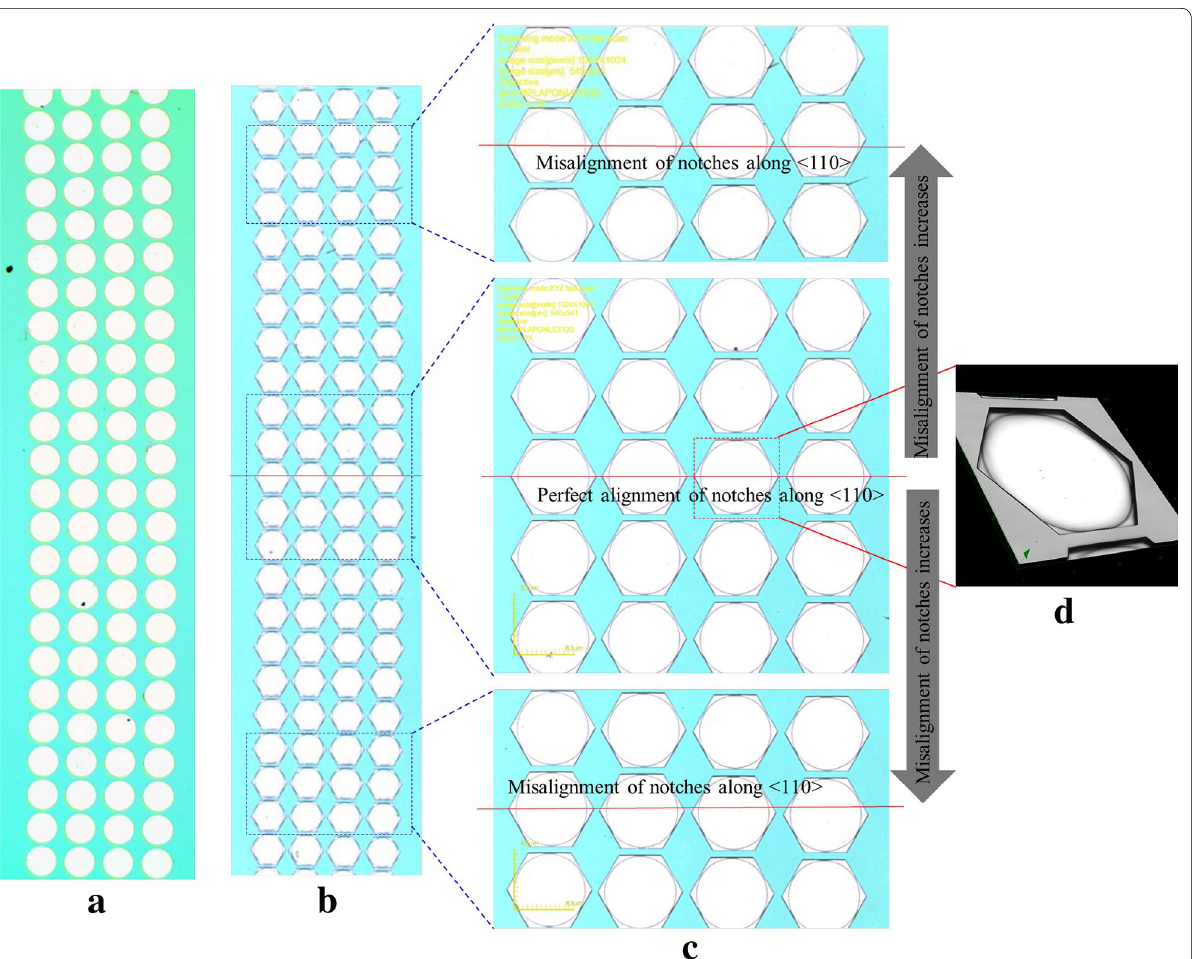
Fig. 5 Optical images of the pre-etched pattern on Si{111} surface: a before etching, b after etching, c zoomed-in view to show the perfectly aligned and misaligned notches of hexagon patterns and d zoomed-in view of hexagon structure. The notches of the four radial hexagons align in a straight line along the precise 〈 110 〉 direction, while the misalignment of notches increases above and below the precise 〈 110 〉